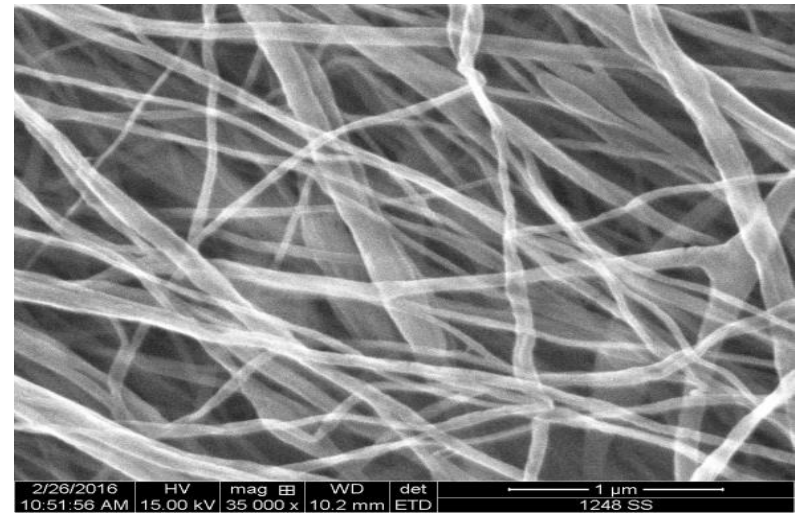
Figure 3. Scanning electron microscope (SEM) image of spider silk nanofibers, with mean diameter ~70 nm.